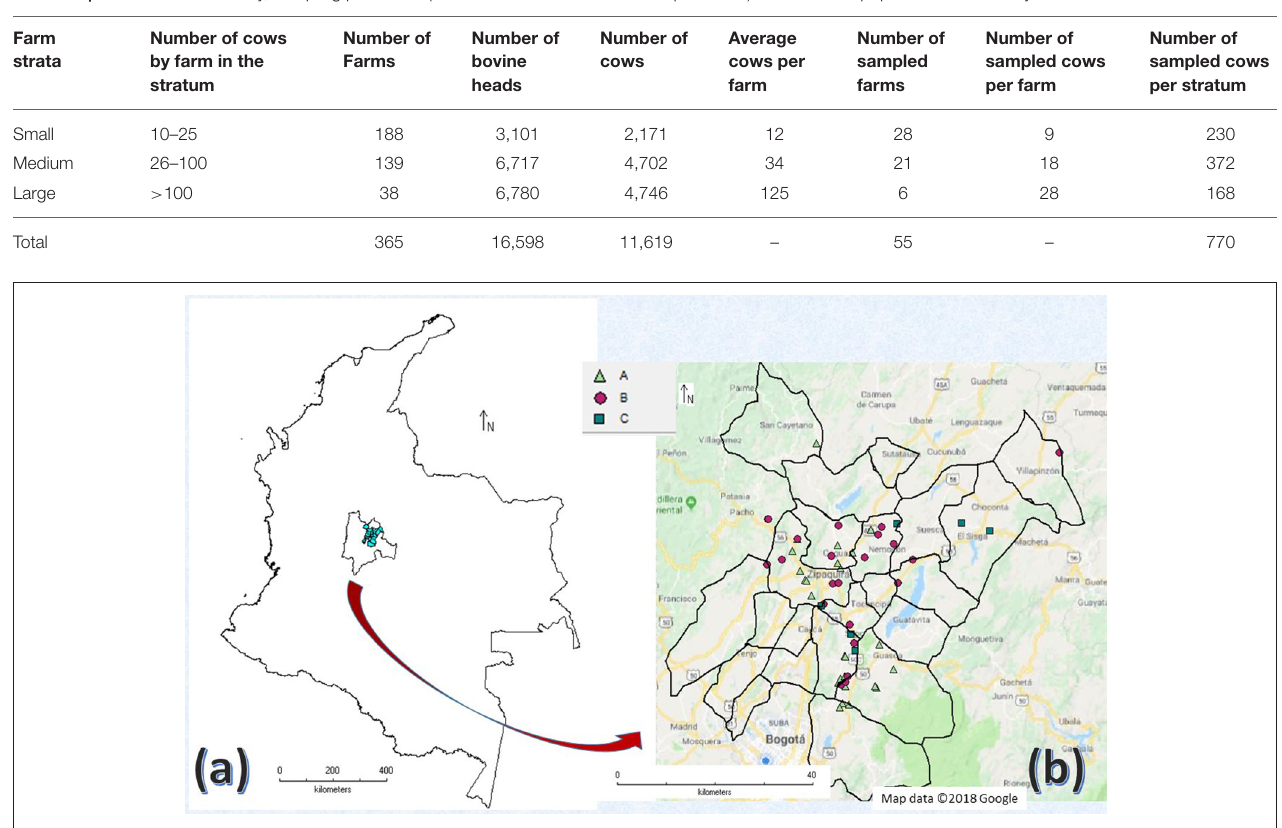
FIGURE 1 | (a) Area of survey location: Area Five of the Bogota plateau at Colombia and Cundinamarca department. (b) Farm locations at survey area discriminated by strata: A, Small; B, Medium; C, Large. (Maps were prepared using the DIVA-GIS software and geographic images from Google